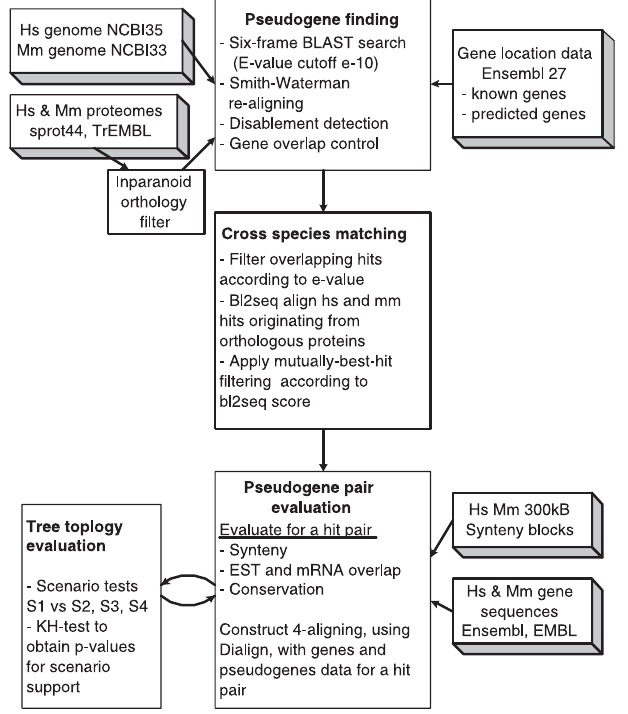
Figure 10. Flow Diagram over the Pseudogene Assignment Process DOI: